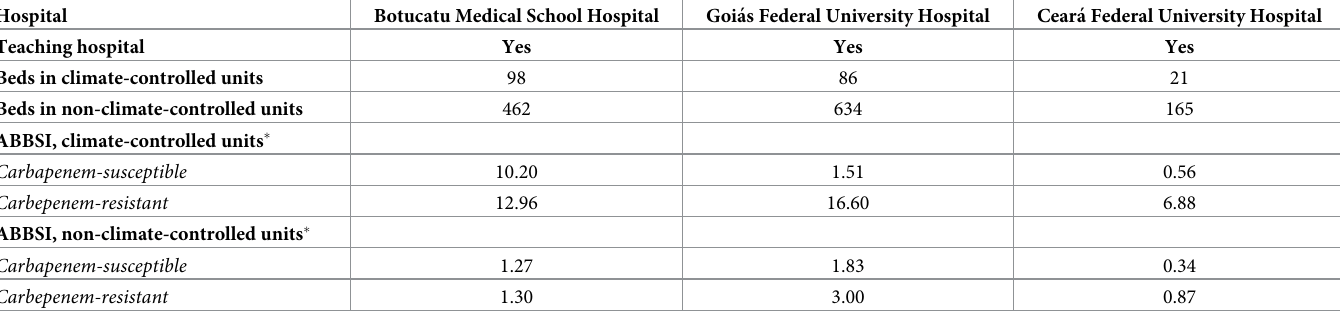
Table 2. Characteristics of hospitals included in this study, alongside with aggregate incidence of Acinetobacter baumanii bloodstream infections (per 10,000